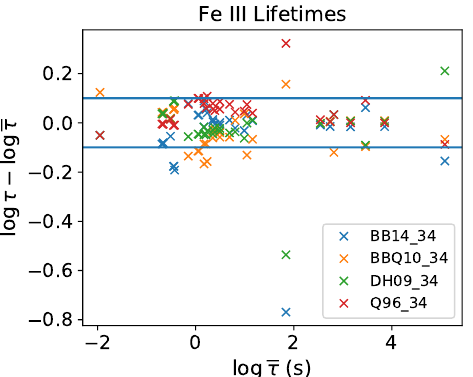
Figure 4. Comparison of Fe III radiative lifetimes computed from the A -values in the atom datasets BB14_34, BBQ10_34, DH09_34, and Q96_34 atom files. For each level, lifetime differences for these datasets with respect to the average value are plotted as a function of the average